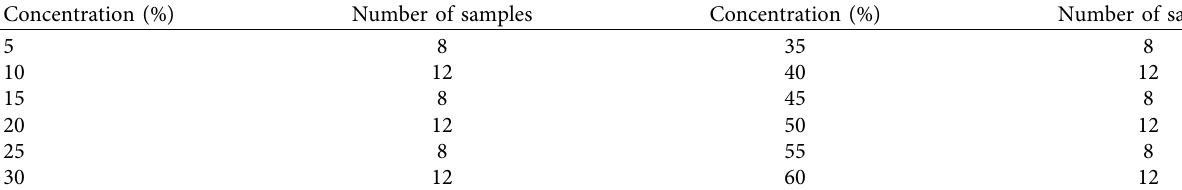
Table 1: Mass percentage and sample number of three types of adulterated samples.